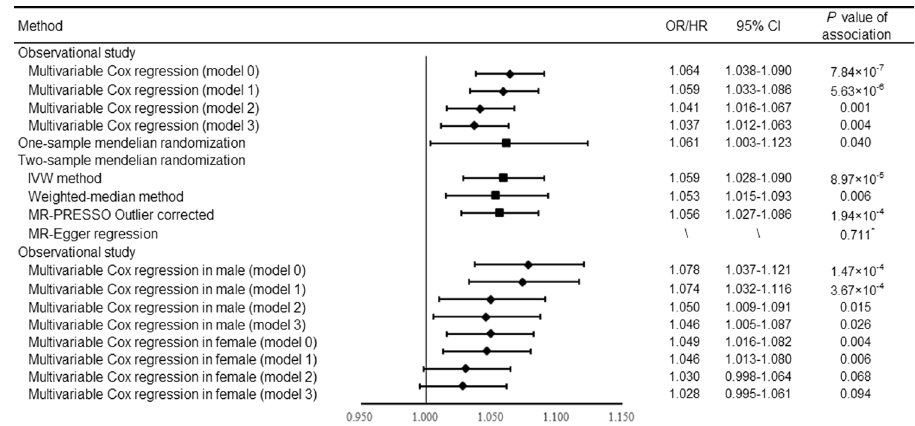
Fig. 1 Forest plot of observational and Mendelian randomization analyses for the relationships of insomnia with fracture risk. The 95% con fi dence interval was presented in the error bar. Model 0 was adjusted for confounders, including age, sex, body mass index, education, smoking, alcohol consumption, physical activity, cognitive impairment, depression, and the use of glucocorticoid medication, benzodiazepines, and antidepressants; Model 1 = Model 0 + BMD; Model 2 = Model 0 + falls; Model 3 = Model 0 + BMD + falls. * the P -value of the intercept term. BMD bone mineral density, CI con fi dence interval, HR hazard ratio, IVW inverse-variance weighted, MR Mendelian randomization, MR-PRESSO MR pleiotropy residual sum and outlier, OR odds ratio.